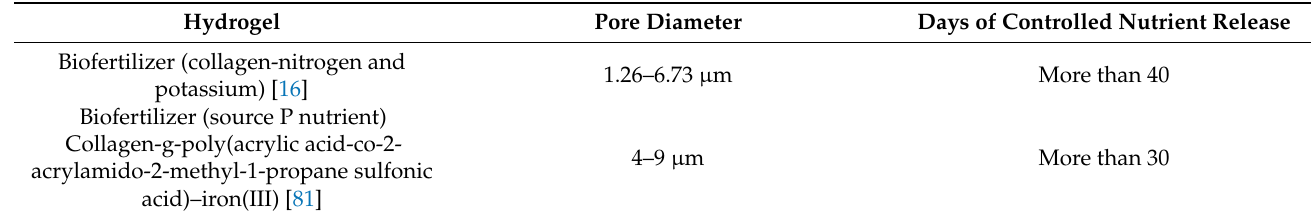
Table 2. Characteristics of